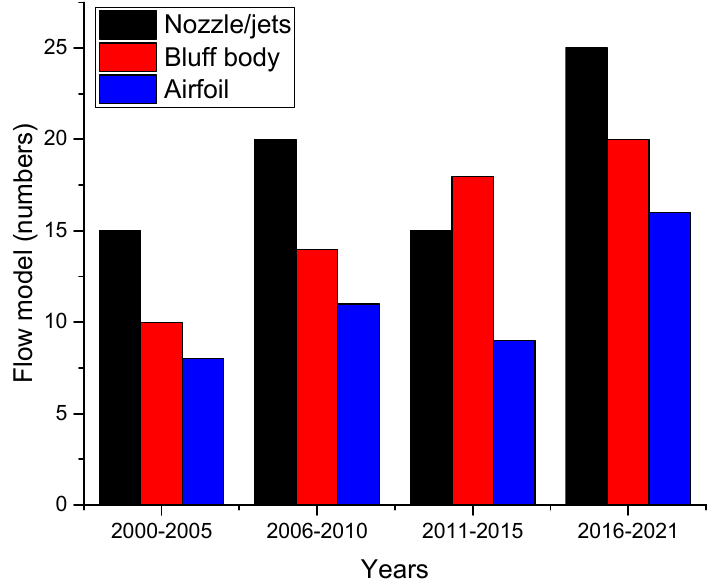
Figure 15. Trend’s inflow model and its control.